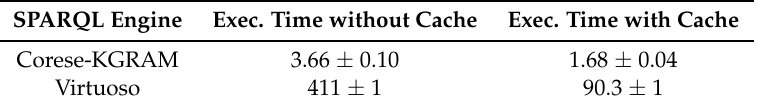
Table 3. Execution time (in seconds) of query Q 1 on Corese-KGRAM and Virtuoso OS Edition, without or with cache